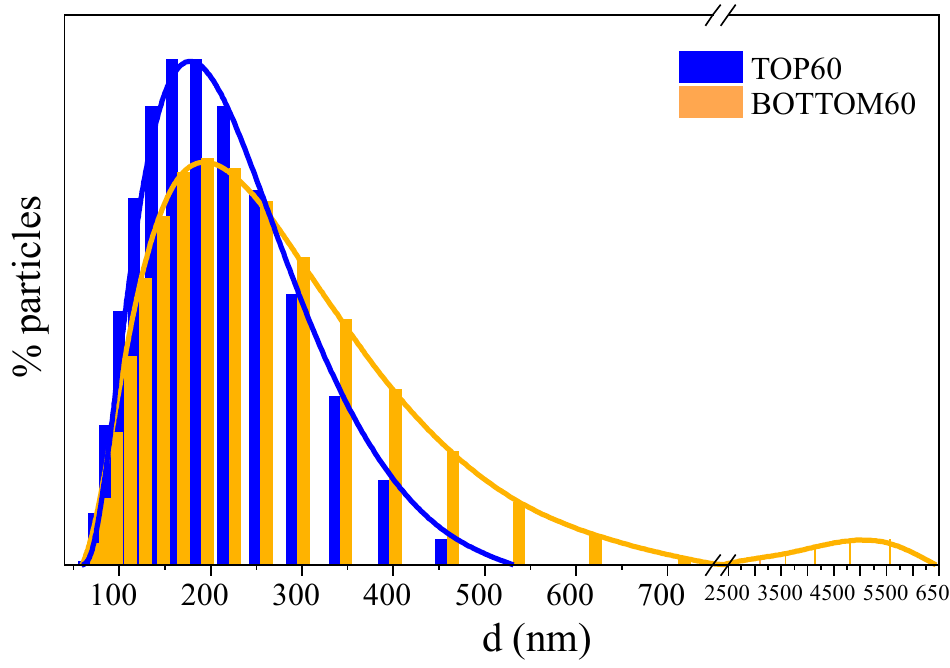
Figure 2. Dynamic light scattering (DLS) diameter (d) distribution curve of TOP60 and BOTTOM60.